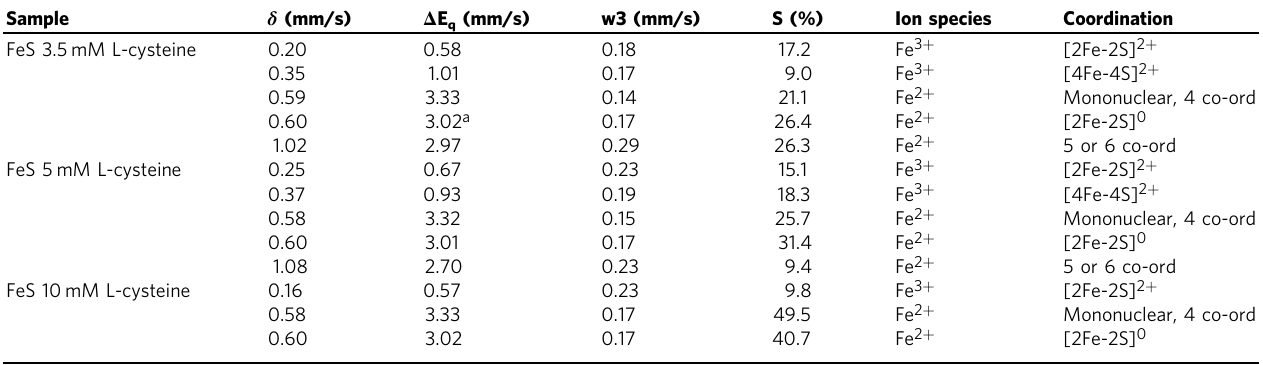
Table 1 Best fi t 57 Fe Mössbauer parameters obtained from the 295 ± 5 K spectra shown in Fig. 4. Sample δ (mm/s) Δ E q (mm/s) w3 (mm/s) S (%) Ion species